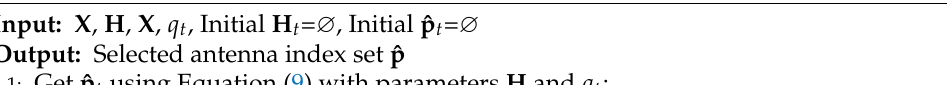
Algorithm 1 Compromised TAS